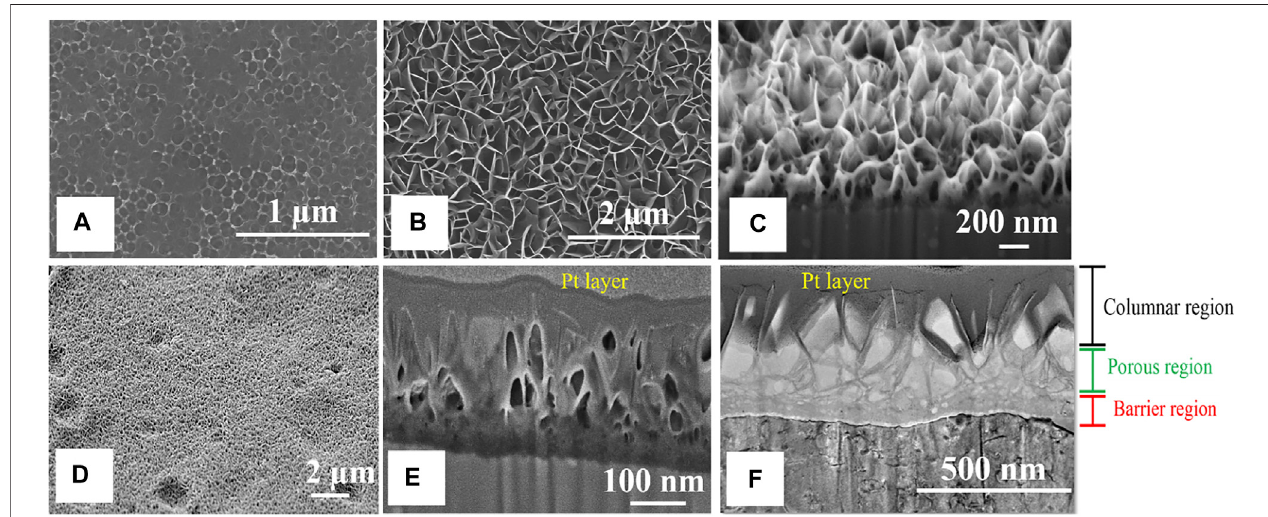
FIGURE1| SEMimagesof (A) thetopviewAAOsurfaceon2024-T3substrate, (B) topview,and (C) cross-sectionalviewoftheLi-AAOsubstrate;SEMimagesof (D) top view and (E) cross-sectional view of the Li-AAO substrate after curing at 55 ° C; (F) TEM image of the cross-sectional view of the Li-AAO substrate after curing at 55 °